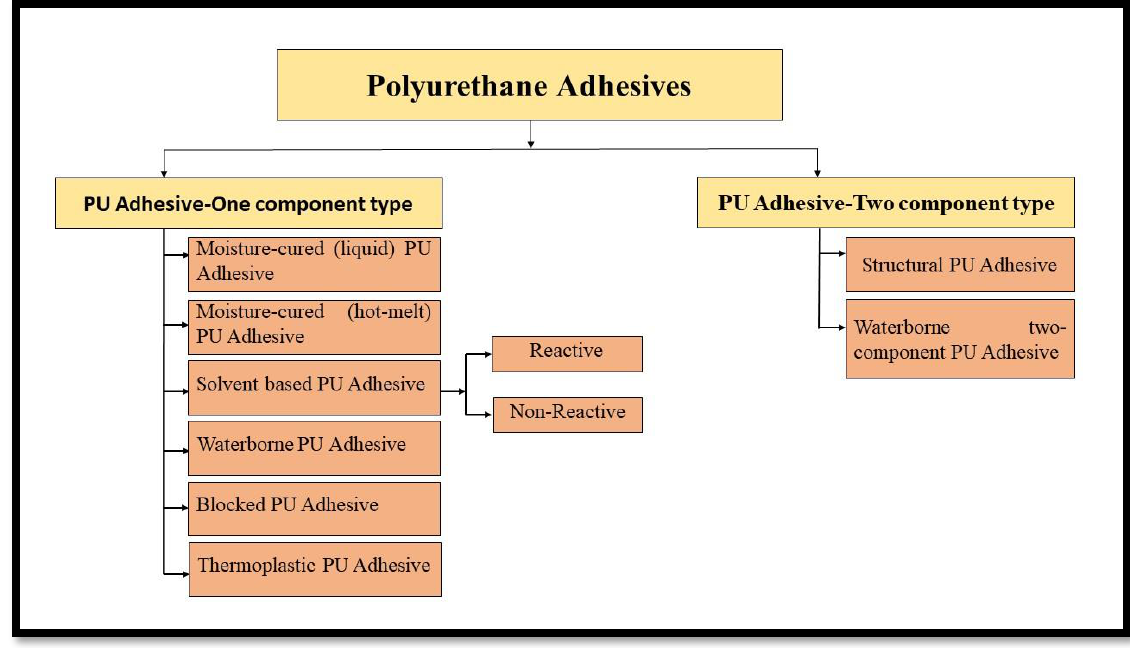
Figure 4. Classification of Polyurethane Adhesives Based on Number of Constituents.